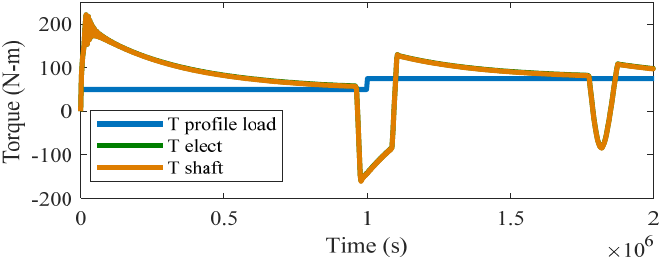
Figure 15. T-Electromagnetic, T-Shaft, T-Mechanical Vs Time during CW with staircase load.